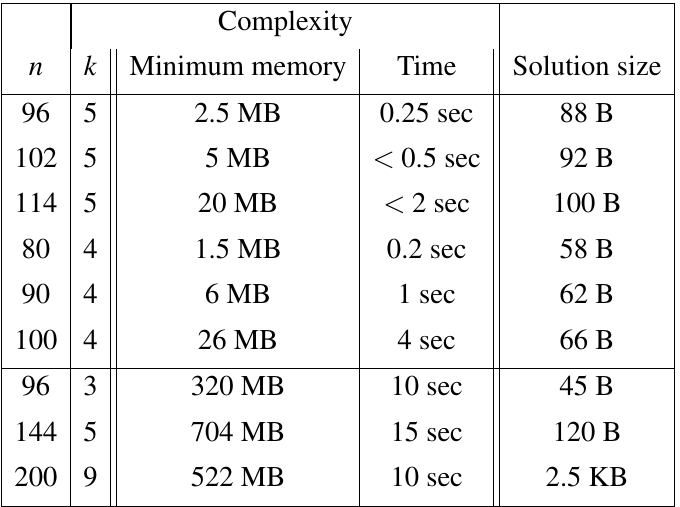
Table 1. Concrete parameters and their security level for Equihash. Memory- full complexities are taken from the analysis of Algorithm 2 (Proposition 2). Memoryless complexity is taken from Proposition 5. Time is counted in hash calls.